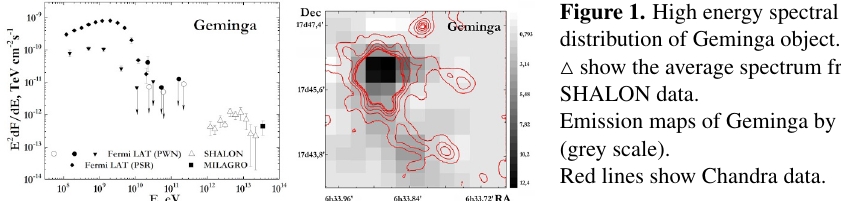
Figure 1. High energy spectral energy distribution of Geminga object. △ show the average spectrum from the SHALON data. Emission maps of Geminga by SHALON (grey scale). Red lines show Chandra data.